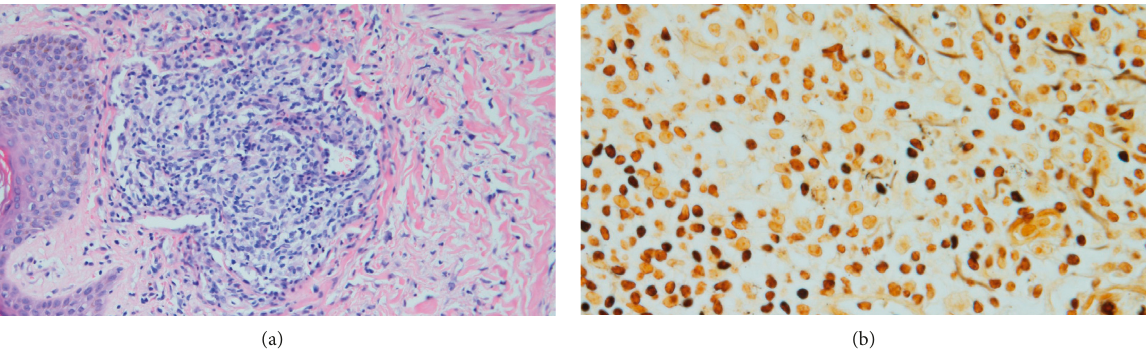
Figure 2: (a) Lymphohistiocytic infiltrate surrounding superficial dermal vessels and histiocytes aggregating into poorly formed granulomas ( × 100 magnification). (b) Warthin–Starry special stain showing numerous spirochaetes amongst the lymphohistiocytic infiltrate ( × 400